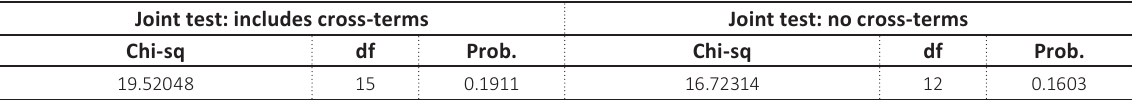
Table 9. VAR residual heteroscedasticity tests